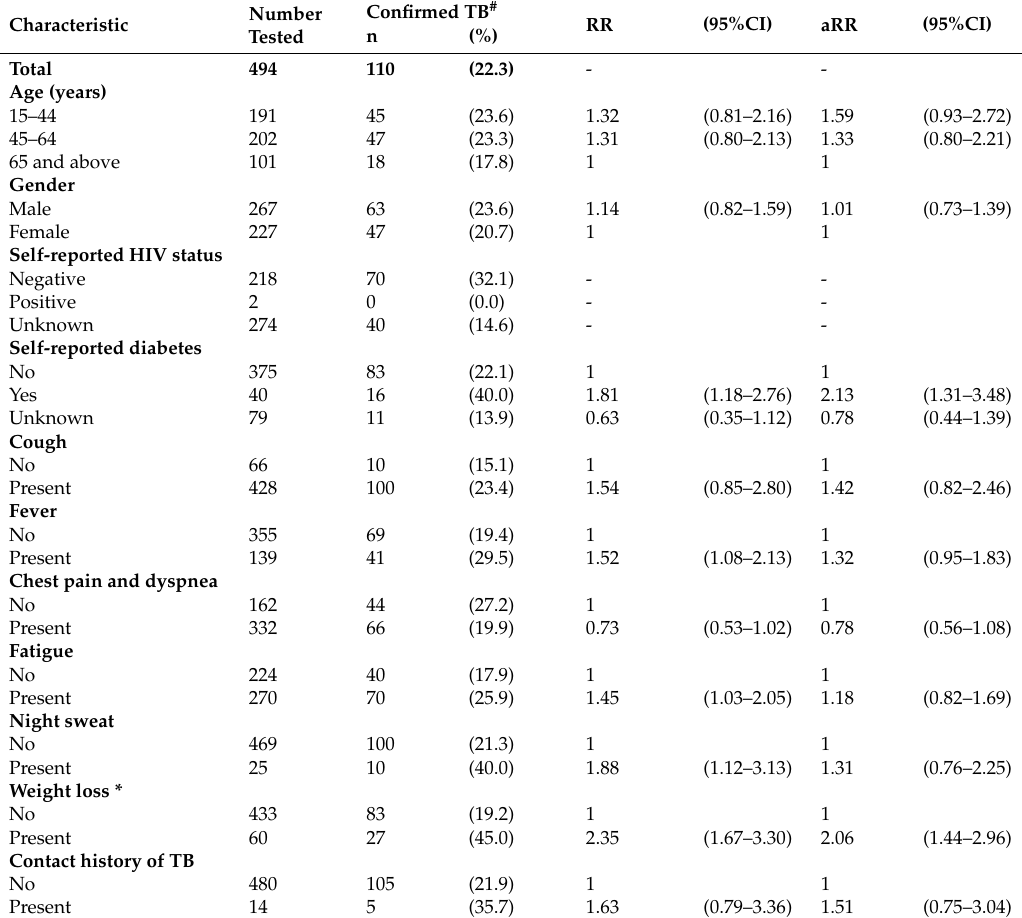
Table 3. Factors associated with diagnosis of TB among the patients who were investigated in the Haiphong International General Hospital in Vietnam, from June to December 2018.